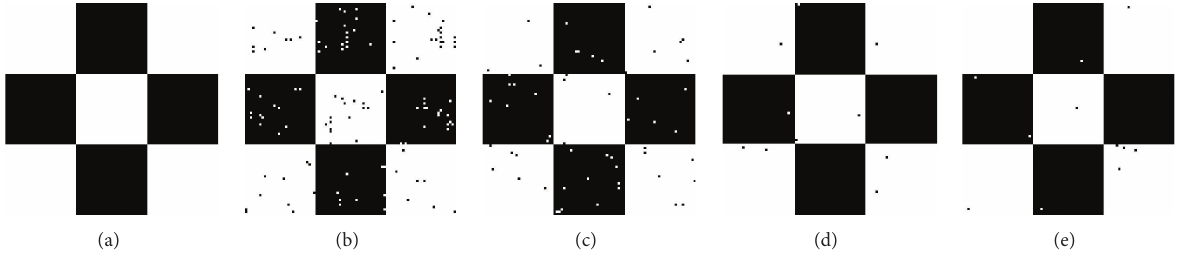
Figure 9: Send and receive figure: (a) original, (b) clipping, (c) C companding, (d) SLM, and (e) the improved